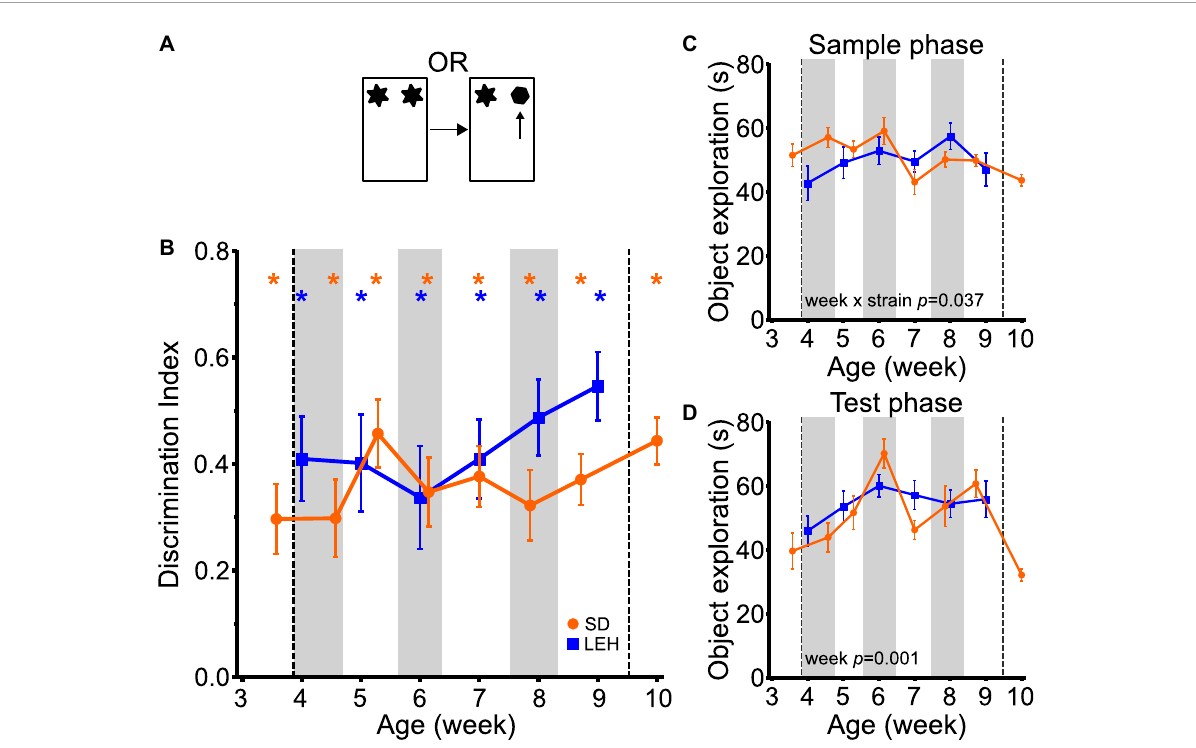
FIGURE2 Object recognition memory is evident from the fourth week of age in LEH and SD rats. (A) Schematic of object recognition task; (B) Object recognition memory performance, expressed as a discrimination index across development. Both LEH and SD rats show significant memory from the first time tested (3rd week of age (P25) for SD and 4th week of age (P28) for LEH)–blue and orange asterisks indicate significant difference from chance (DI = 0) for LEH and SD rats respectively, based on one-sample t -tests. * p < 0.05. To compare directly between strains and across ages, the data were binned into 6 “week of age” bins (from ∼ 4 weeks to ∼ 9 weeks old), because the exact postnatal day of testing differed between the two strains (see section “Materials and methods” for details of bins). The different week of age bins are indicated on panels (B–D) with alternating vertical shading, with the first grey shaded area corresponding to 4 weeks old. As only the SD rats were tested younger than 4 weeks old (P25&P26) and older than 9 weeks old (P70&P71) these data points were not included in the cross-species comparisons (vertical dashed lines). The p -values for significant main effects or interactions from the LME-ML analyses between strains and weeks of age are stated within each graph. For OR memory, no significant effects of strain, week or strain × week interactions were detected; (C) Object exploration during sample phase for each testing time point for both LEH and SD rats. A significant week × strain interaction was detected; (D) Object exploration during test phase for each testing time point for both LEH and SD rats. Only a significant effect of week was detected. p -values from one-sample t -tests have been corrected for false discovery rate using the Benjamini-Hochberg procedure. [SD]: n = 16 for all time points; [LEH]: n = 13 except P35&P64 where n = 12. For details on sample sizes, t , and p -values for one-sample t -tests, see